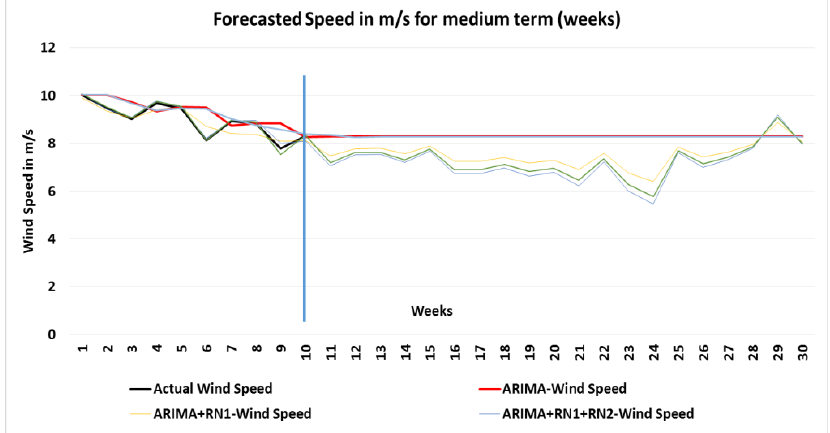
Figure 14. Forecasted Speed in m/s for medium term (weeks).